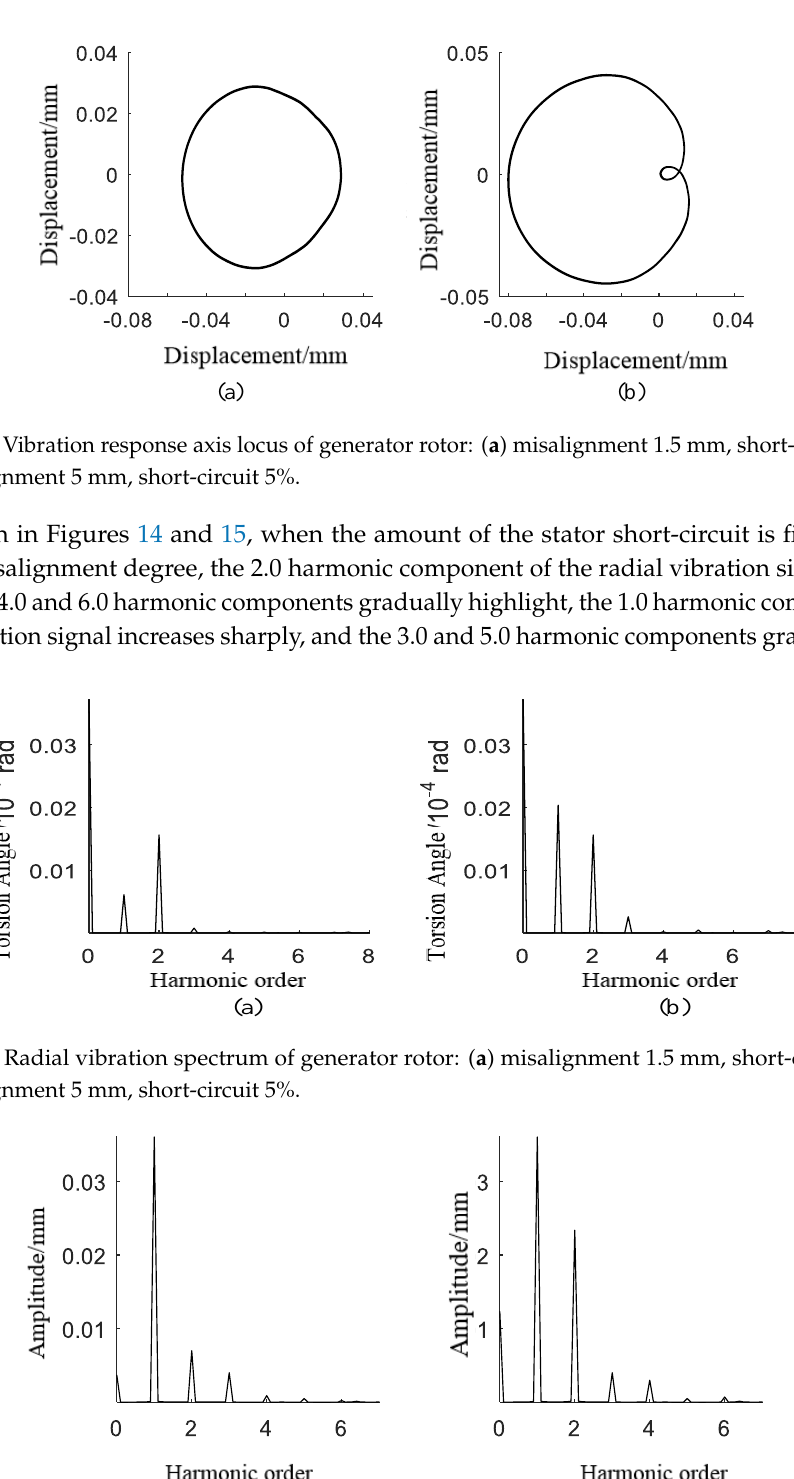
Figure 12. Vibration response axis locus of generator rotor: ( a ) misalignment 1.5 mm, short-circuit 5%; ( b ) misalignment 5 mm, short-circuit 5%.